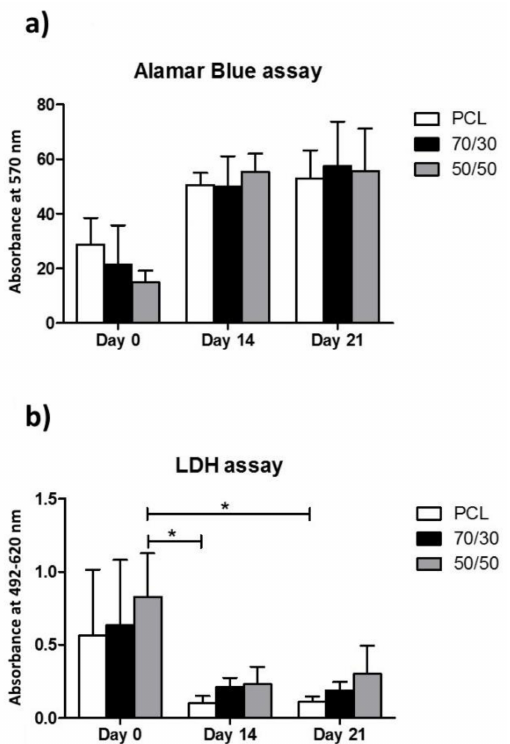
Figure 8. ( a ) Alamar Blue ® and ( b ) LDH assay to evaluate the cell vitality and cytotoxicity, respec- tively, of pure PCL, 70/30, and 50/50 scaffolds at 0, 14. and 21 days. Alamar Blue and LDH graphs were expressed as mean ± SD. Data were compared by the Kruskal–Wallis test, followed by Dunn’s post-hoc test, with * p <